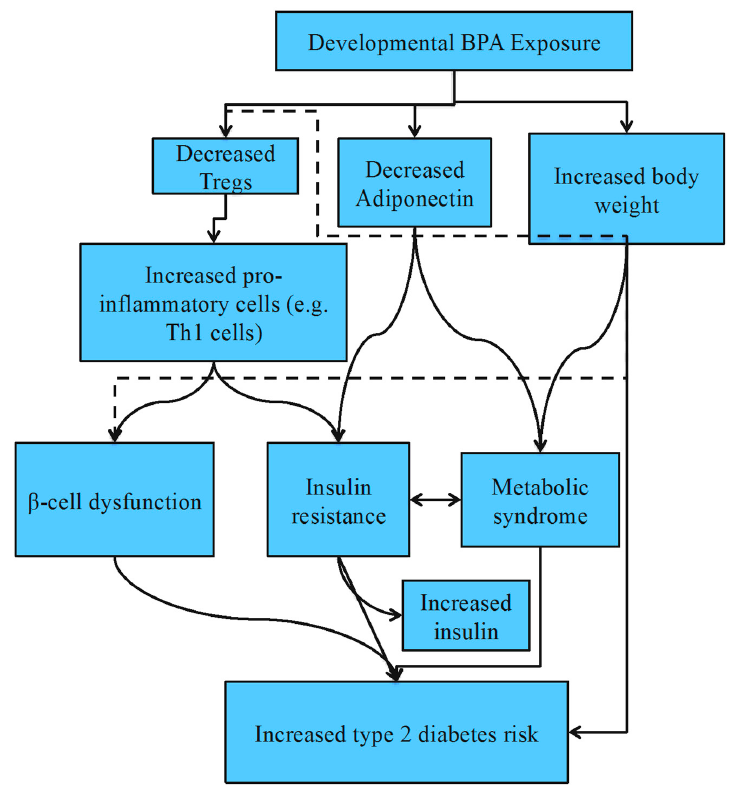
Figure 1. Proposed mechanisms for increased type 2 diabetes risk following developmental bisphenol A (BPA) exposure.